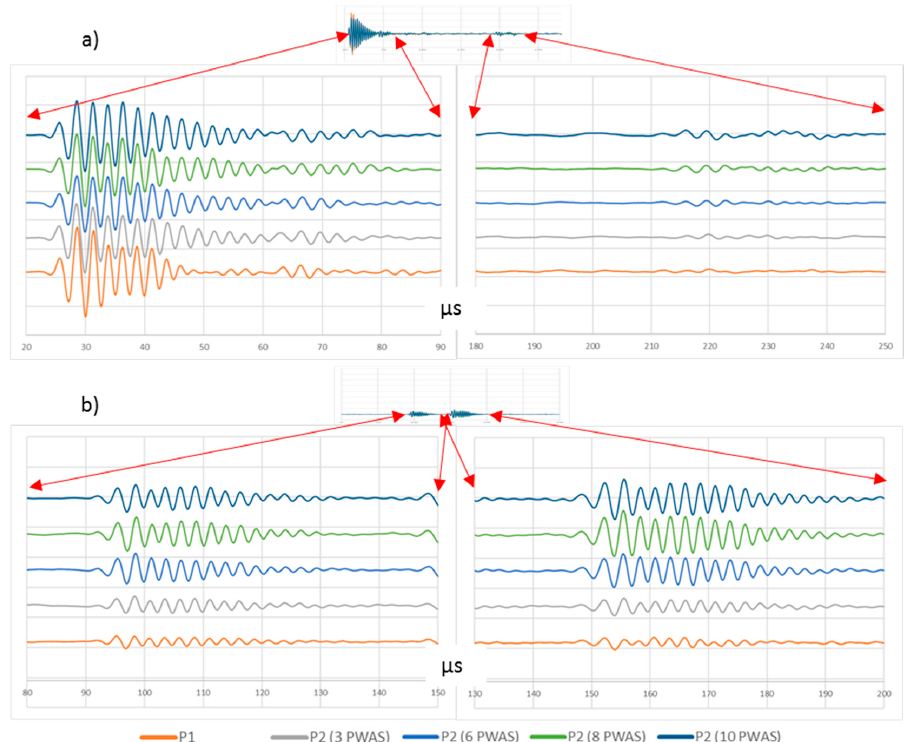
Figure 8. Signals obtained in PWAS ( a ) R1 and ( b ) R4 in UGWT according to procedures P1 and P2 using 3, 6, 8, and 10 PWAS as wave emitters. In all cases, the vertical scale is 100 mV / div.